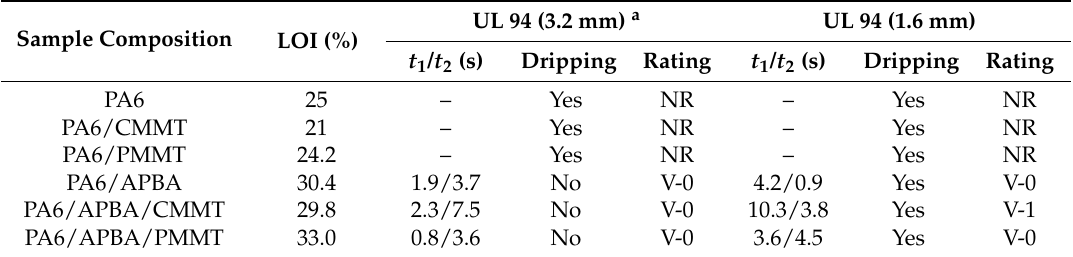
Table 4. LOI and UL 94 tests results of PA6 and PA6 composites.